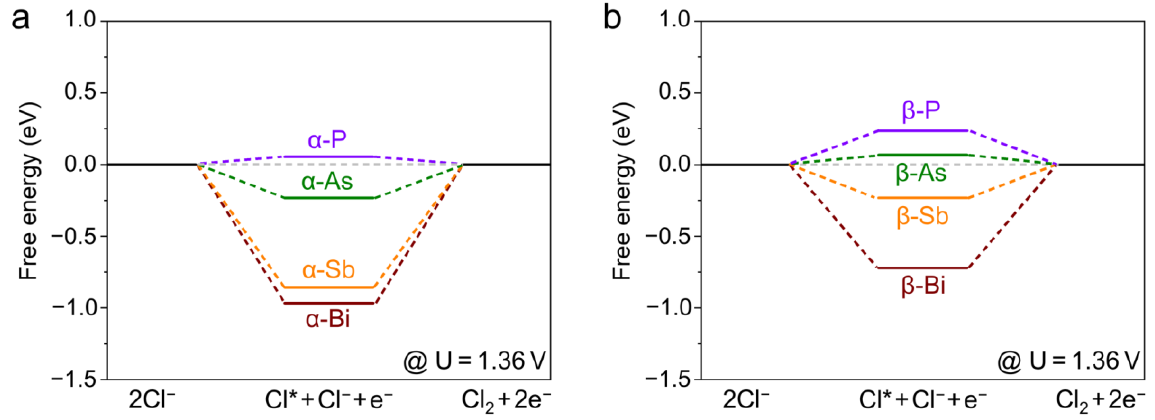
Figure 2. Gibbs free energy diagrams for CER over ( a ) α and ( b ) β phase of group-VA monolayers. Table 3. Summary of the experimental (η exp ) and thermodynamic overpotentials(η td ) of reported electrocatalysts for chlorine evolution. a